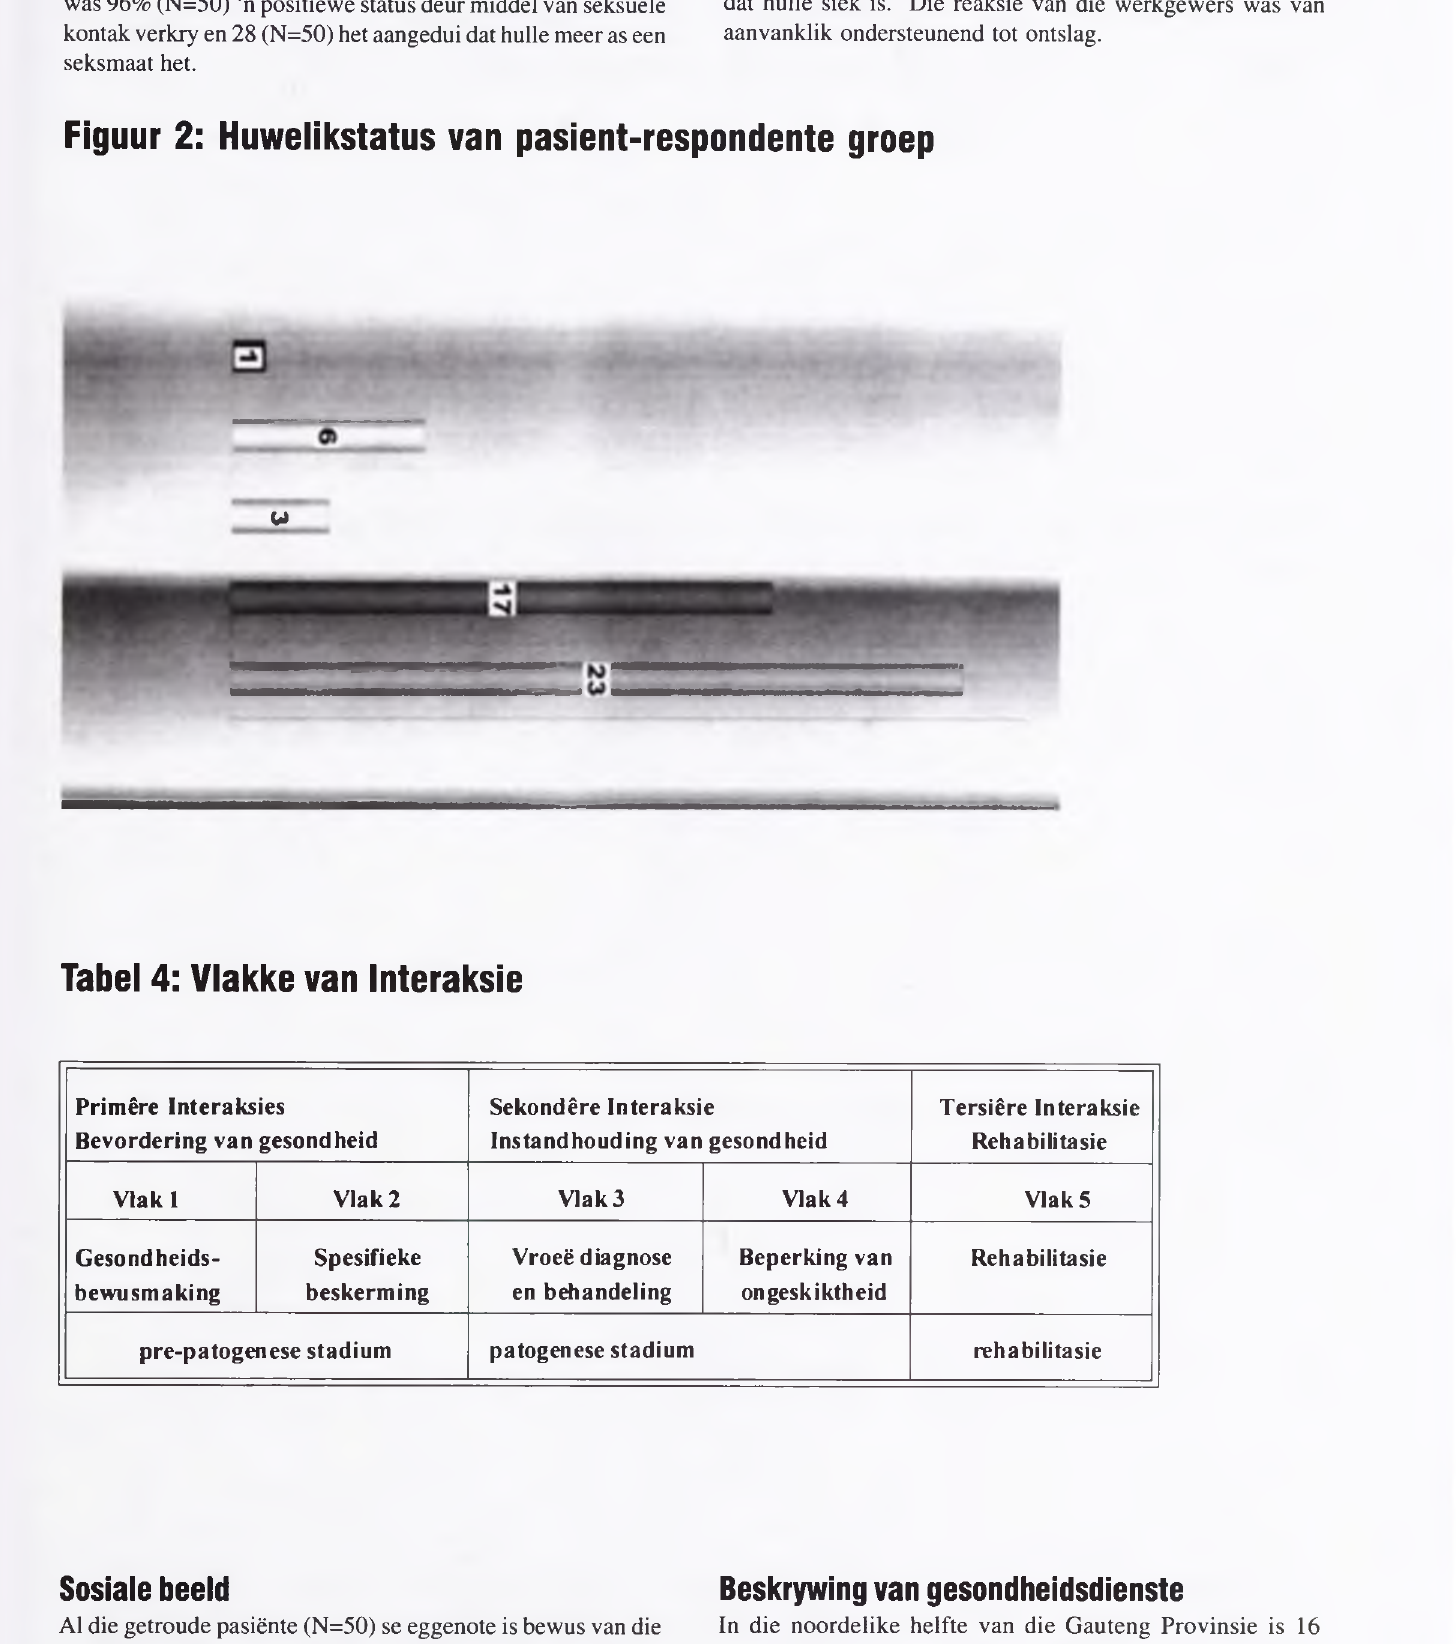
Figuur 2: Huwelikstatus van pasient-respondente groep